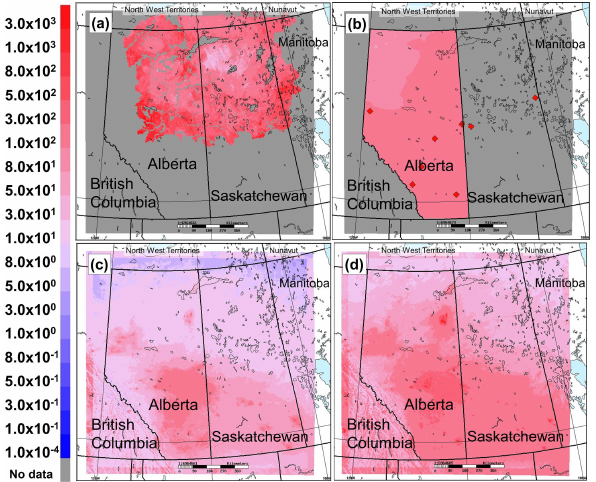
Figure 11. Base cation fluxes (eqha − 1 yr − 1 ). (a) Total export flux of base cations from aquatic ecosystem catchments. (b) Atmo- spheric deposition flux of base cations from surface data collected between 1994 through 1998, monitoring station locations shown as red diamonds, (c) base cation deposition from GEM-MACH, mak- ing use of Wang et al. (2015) speciation, (d) GEM-MACH BC dep corrected using and precipitation measurements and aircraft obser- vations of fugitive dust.